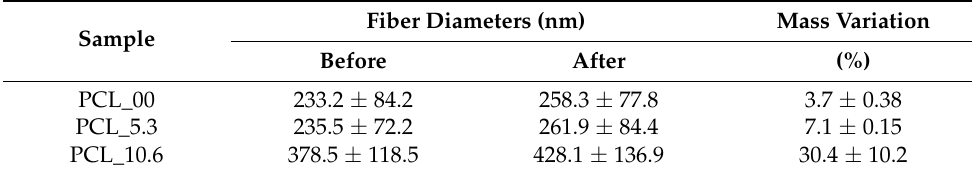
Table 3. Comparative diameters and mass variation after assay of the electrospun nanofibers before and after swelling with lyophilized electrospun